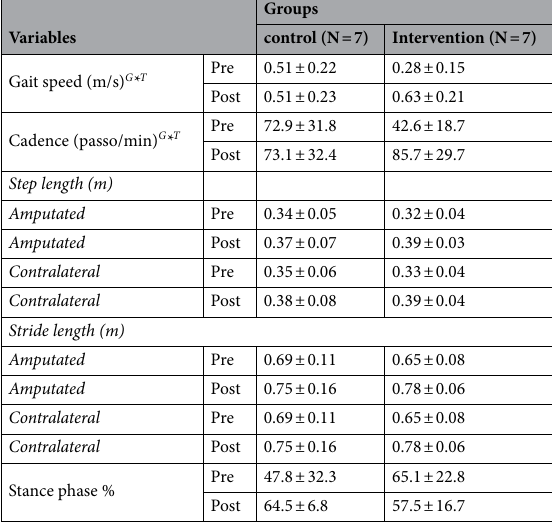
Table 7. Temporal-spatial parameters of gait, in each amputee group pre- and post-intervention. G * T Group*time interaction ( P < 0.05); † Pre time difference ( P < 0.05).